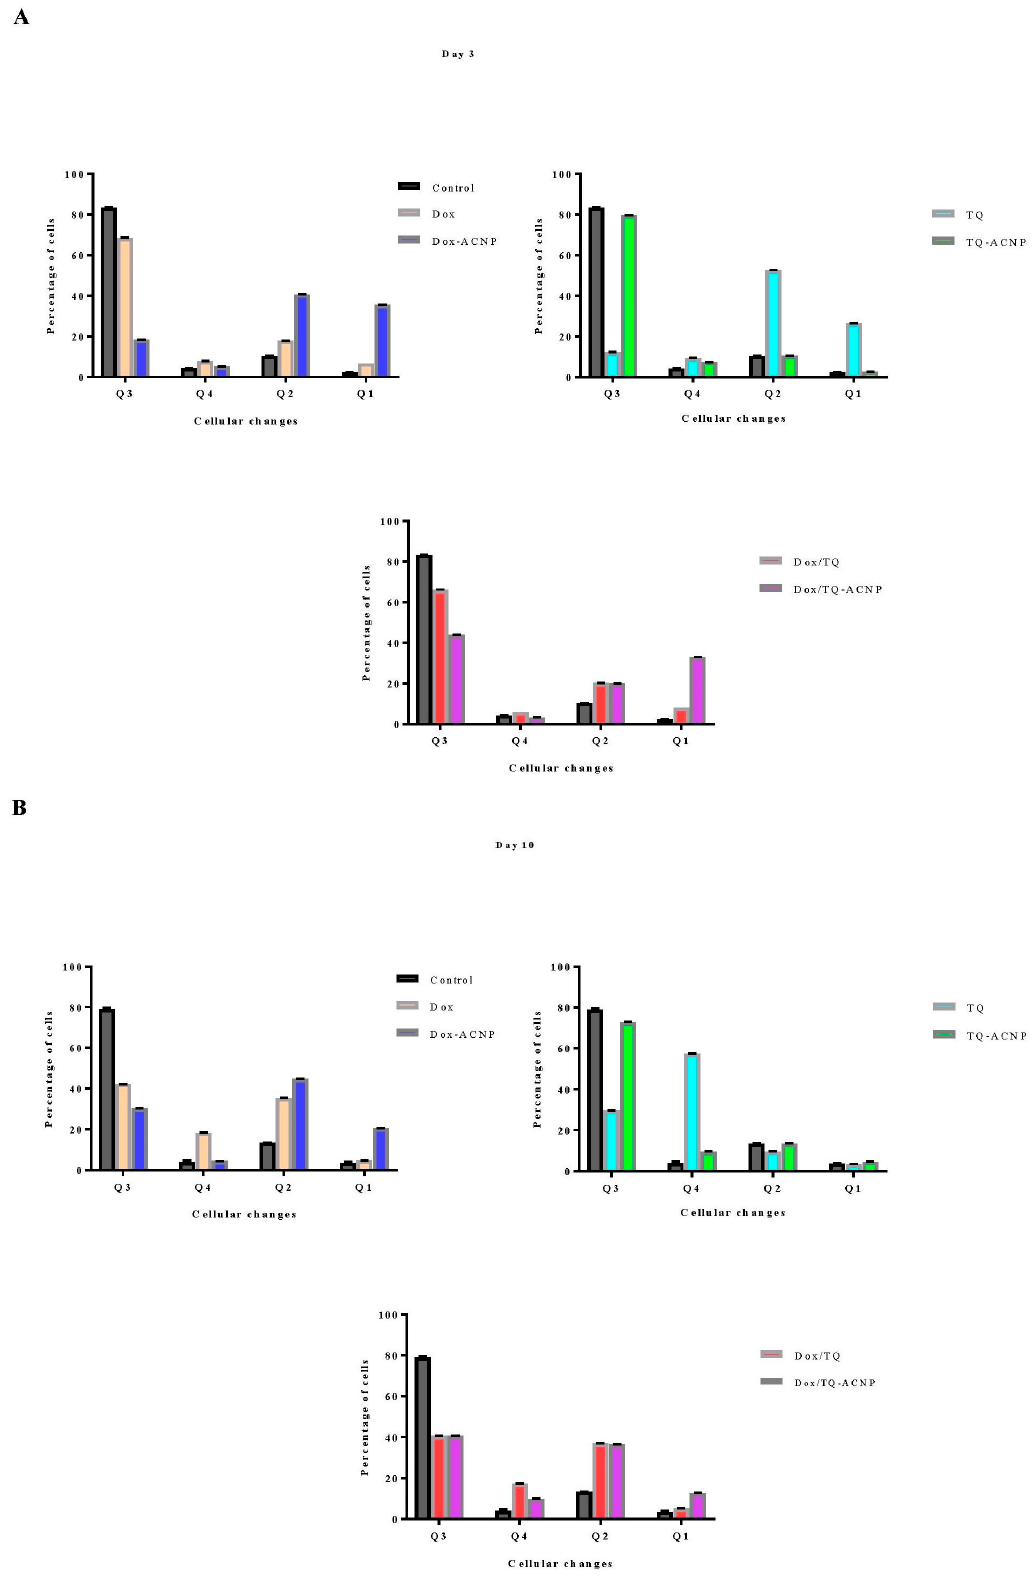
Figure 8. Estimation of percentage cytopathology in MDA MB 231 cells that were untreated and treated with free and drug-loaded nanoparticles. Percentages of viable cells (Q3), early apoptosis (Q4), late apoptosis (Q2) and necrosis (Q1) at day 3 ( A ) and day 10 ( B